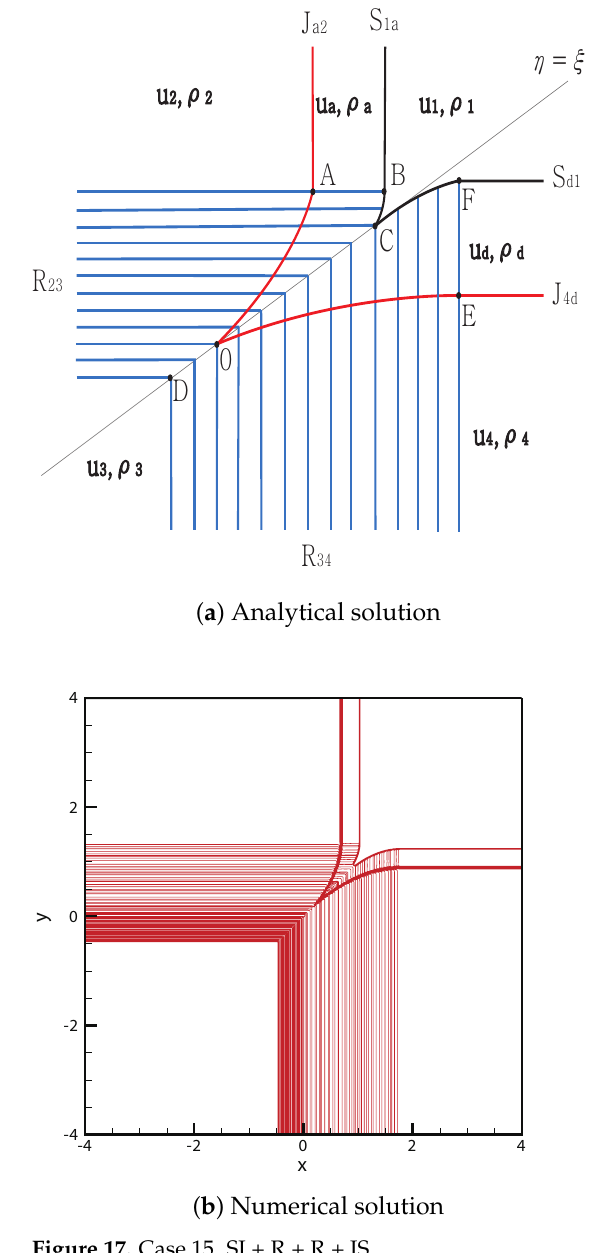
Figure 17. Case 15. SJ + R + R +